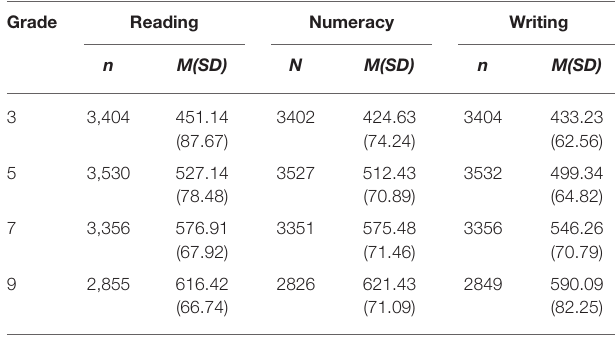
TABLE 1 | Numbers of participants, means, and standard deviations by grade level and